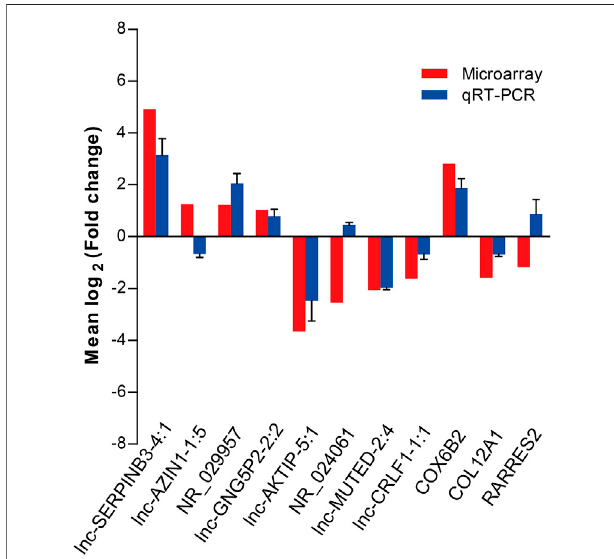
FIGURE 2 | qRT-PCR validation of eight differentially expressed lncRNAs and three mRNAs selected by the microarray assay. Comparison of lncRNA or mRNA expression levels obtained by microarray and qRT-PCR analysis. Upregulated and downregulated lncRNAs or mRNAs are indicated by bars above and below the horizontal axis, respectively. The data from qRT-PCR was shown as mean ± standard deviation